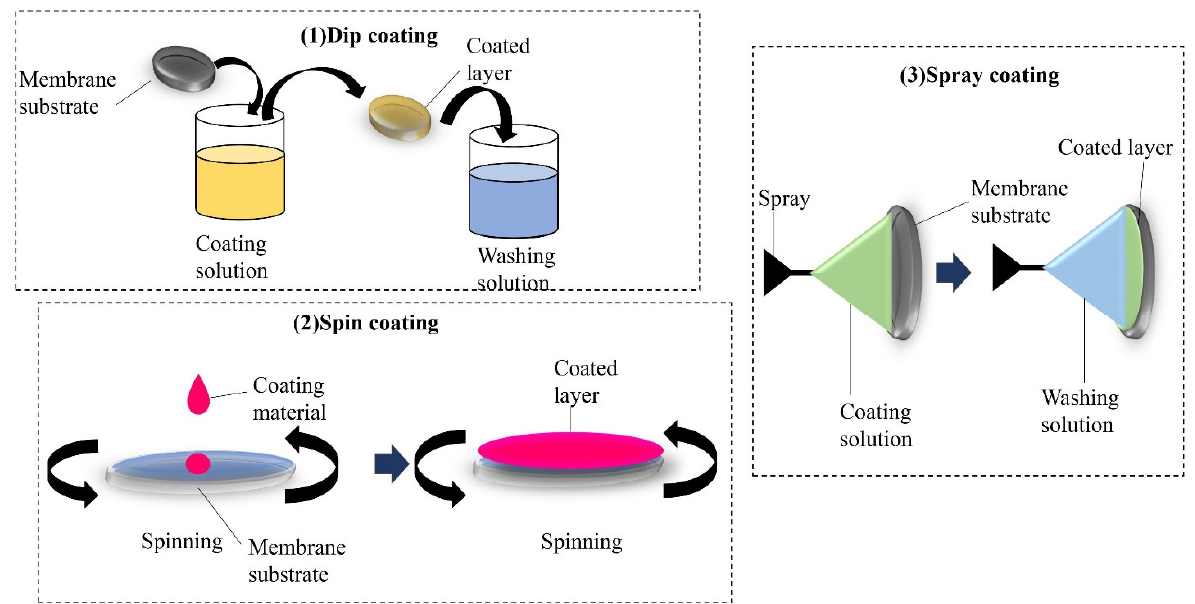
Figure 11. Different coating techniques to form adsorptive membranes.